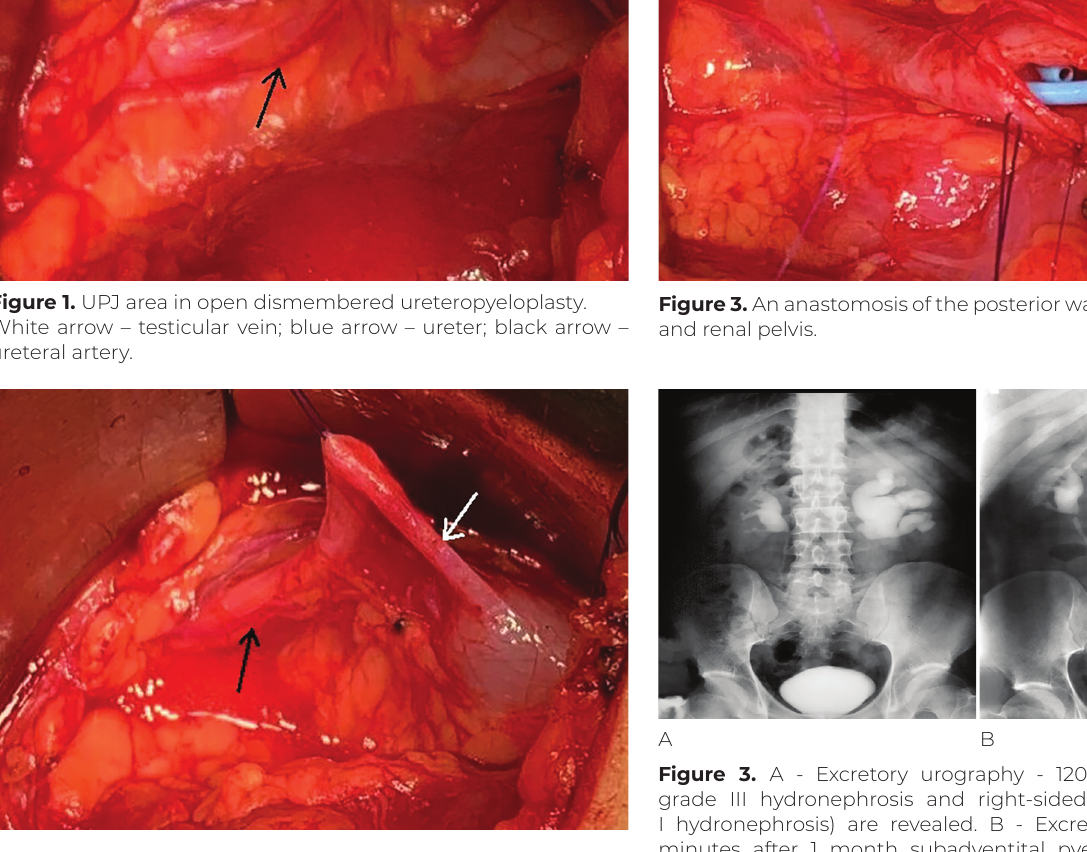
Figure 2. Incision and dissection adventitial layer. White arrow – ureter; black arrow – ureteral artery.